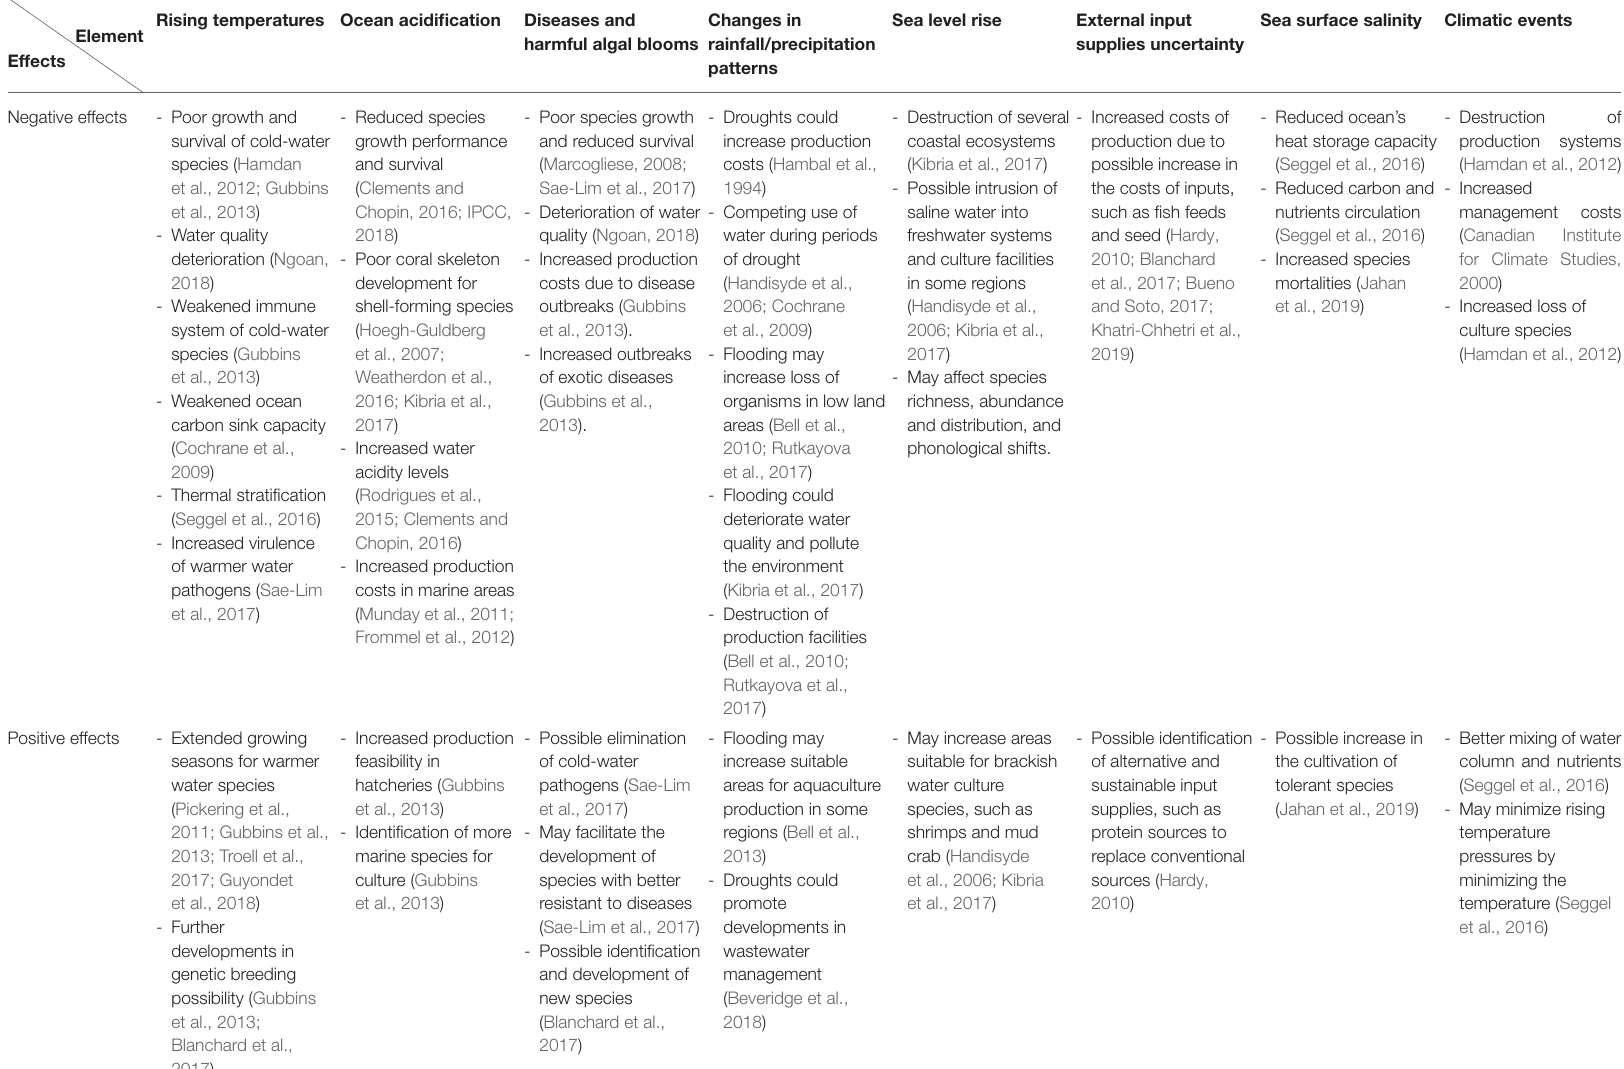
TABLE 1 | Summary of the various elements of climate change and their effects on aquaculture production.